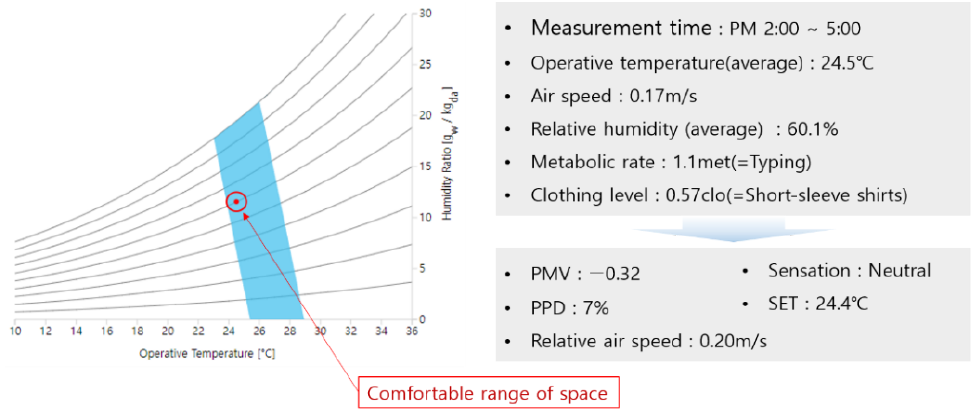
Figure 15. Indoor air quality measurement of Office Space B: Office Space B comfort level analysis result as of 10 August 2021.